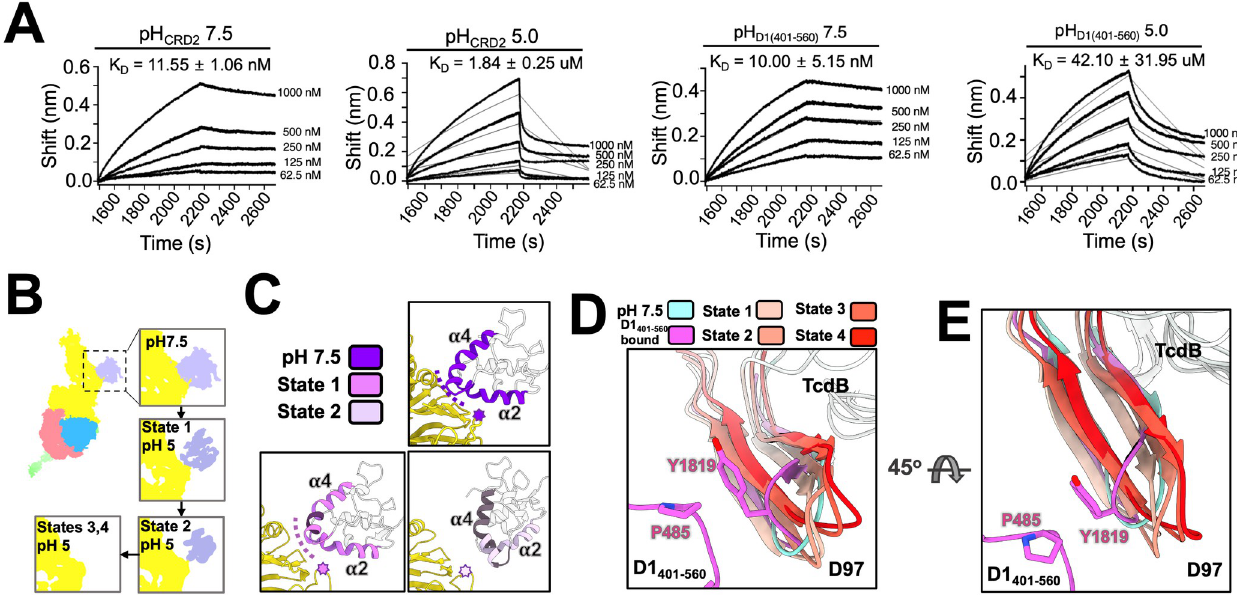
Fig 3. Interactions between TcdB and its receptors under different pHs. (A) Binding kinetics between TcdB and receptors are measured by BLI. The calculated binding affinities of TcdB to the 2 receptors, under pH 7.5 or pH 5, are labeled above each diagram. This measurement was calculated based on 2 biological replicates with standard deviations listed for each sample (raw data in S3 Data). (B) The structure comparisons of the TcdB-CRD2 complex at pH 7.5 and the 2 states at pH 5. (C) The helices ( α 2 and α 4) of CRD2 that interact with TcdB are colored for each state. Dashed curves label the CRD-binding groove. Stars label the CRD-binding loop. Dark gray color labels regions in α -helices 2 and 4 that lack the cryo-EM density. The buried surface areas, calculated based on the model for the complex of TcdB and CRD2 under pH 7.5, state 1 and state 2 are around 700, 150, and 80 Å 2 , respectively. (D) The movement of the β -sheet (residues 1,812–1,827) in the D97 region are shown and color coded for each state. Tyr1819 of TcdB and its interaction partner Pro485 of CSPG4 are shown. (E) The same region rotated 90˚ from Panel D. BLI, bio-layer interferometry; CRD, cysteine-rich domain; CRD2, cysteine-rich domain of frizzled-2; TcdB, Toxin